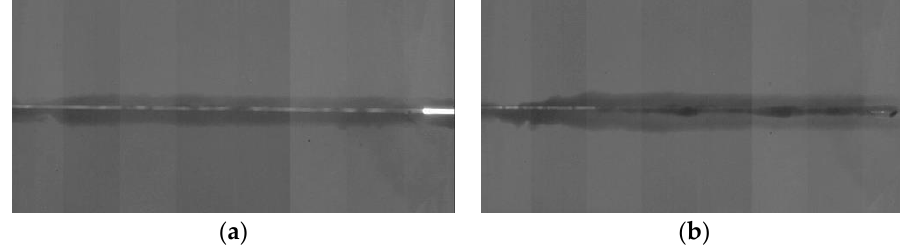
Figure 4. X-ray NDT photograph: ( a ) X-ray NDT for weld seam in Sample 1, ( b ) X-ray NDT for weld seam in Sample 2.